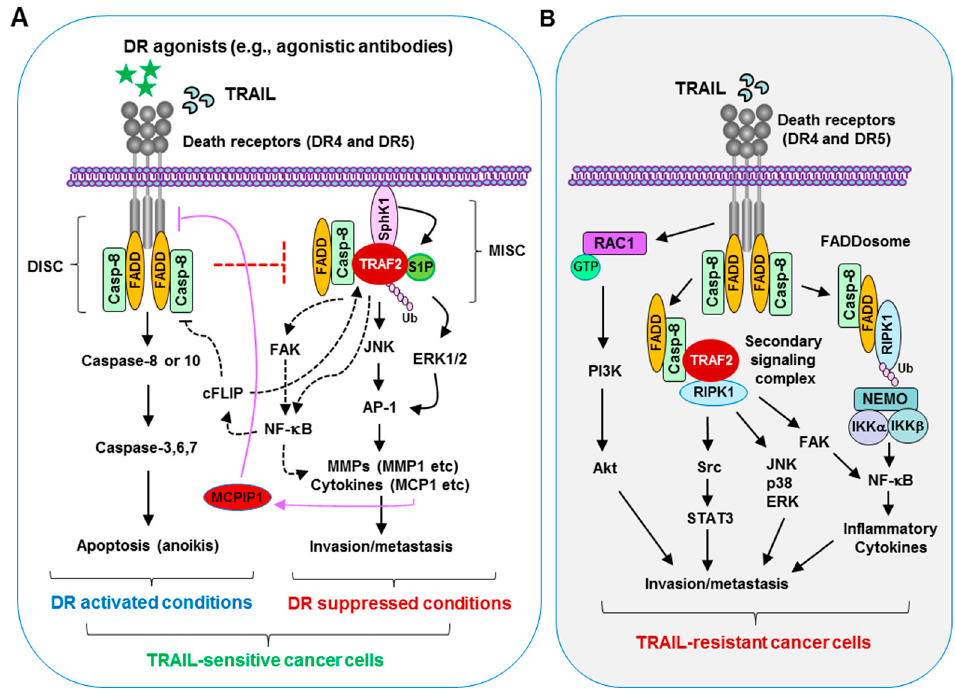
Figure 1. Tumor necrosis factor-related apoptosis-inducing ligand (TRAIL)/death receptor signaling in the regulation of apoptosis and metastasis of cancer cells. ( A ) Under normal apoptotic conditions (e.g., in cancer cells sensitive to TRAIL with activated death receptor pathway), TRAIL ligation with its death receptors (DR4 and DR5) or an agonistic antibody binding to a corresponding death receptor (DR4 or DR5) on the surface of cancer cells induces the formation of the death-inducing signaling complex (DISC) involving Fas-associated death domain (FADD) recruitment of pro-caspase-8 via its death effector domain, resulting in caspase-8 or -10 activation followed by cleavage and activation of caspase-3, -6, and -7, and eventual execution of apoptosis or anoikis. This mechanism restricts the formation of the metastasis and invasion signaling complex (MISC) and subsequently suppresses cell invasion and metastasis. When TRAIL/death receptors are inhibited or their functions are compromised, available FADD and caspase-8 may recruit and stabilize TNF-receptor-associated factor (TRAF)2 with the help of S1P, resulting in enhanced TRAF2 polyubiquitination and activation, likely through a self-ubiquitination mechanism. This will further lead to activation of ERK/JNK/AP-1 signaling and NF- κ B activation, which activates MMPs (e.g., MMP1) and enhances the release of inflammatory cytokines (e.g., monocyte chemoattractant protein 1 (MCP1)) that promote invasion and metastasis of cancer cells. MCP1 may induce monocyte chemotactic protein-induced protein-1 (MCPIP1) expression, leading to a reduction in DR5 levels, including cell surface DR5; this favors MISC formation and metastasis. ( B ) In TRAIL-insensitive cells, TRAIL treatment will induce the formation of a second signaling complex or FADDosome, resulting in the activation of multiple protein kinases such as NF- κ B, JNK, p38, ERK, and Src that are involved in the positive regulation of invasion and metastasis of cancer cells. In KRAS -mutated cancer cells, TRAIL/DR5 activation can activate the Rac1/PI3K/Akt axis, promoting cell invasion and metastasis. RIPK1, receptor-interacting serine/threonine-protein kinase 1. DR, death